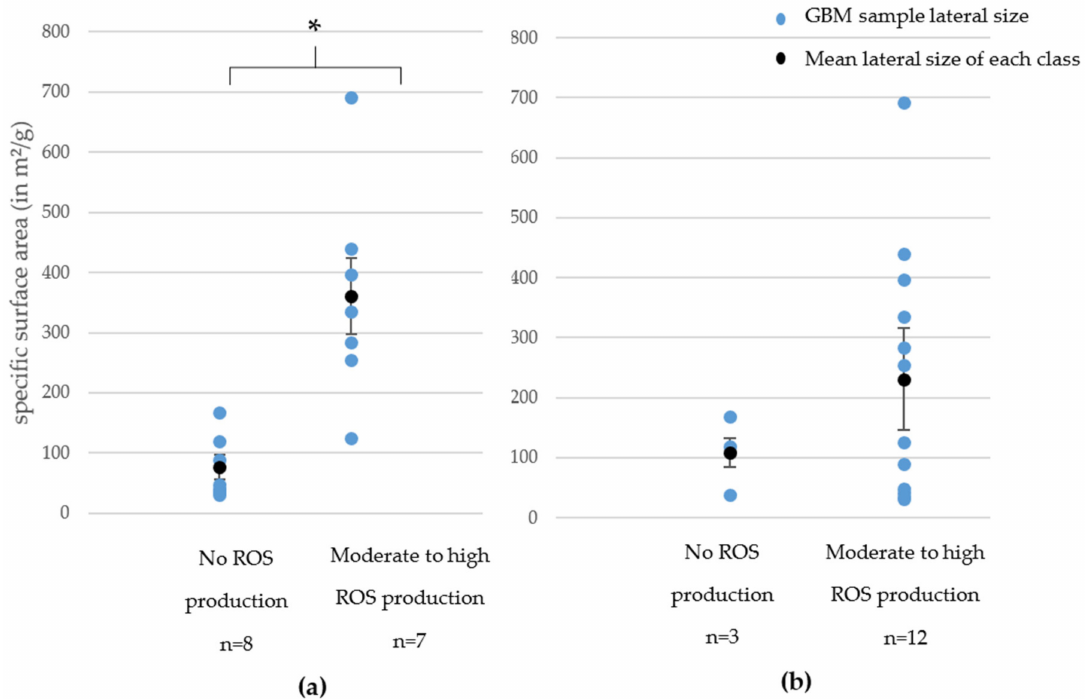
Figure 5. Structure–activity relationship between ROS production after 90 min ( a ) or 24 h ( b ) of exposure and specific surface area. * = p < 0.05 (Student